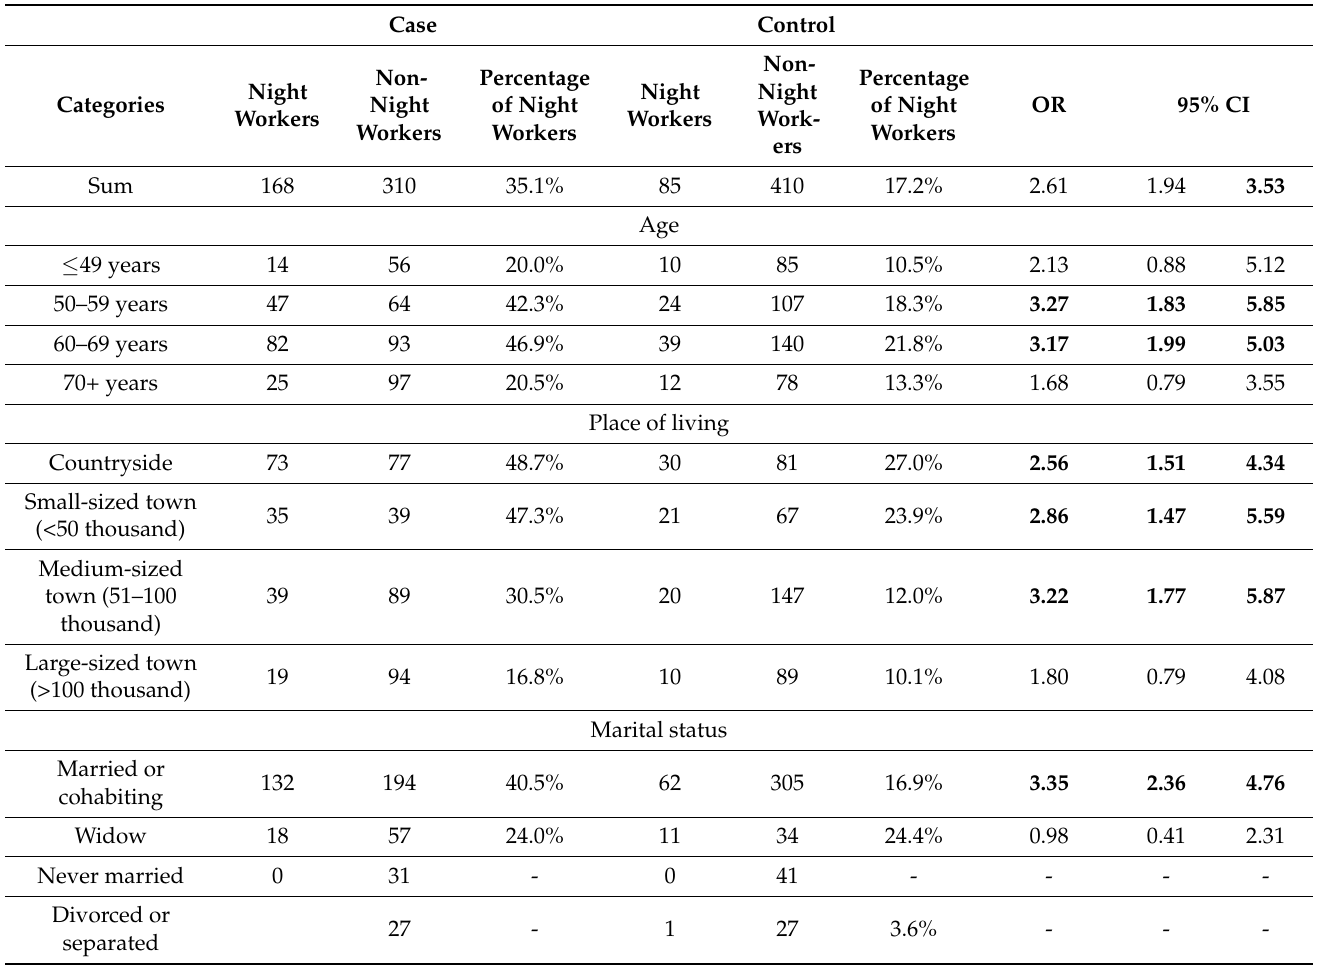
Table 1. The crude odds ratios of breast cancer in night workers compared to non-night workers in each category.